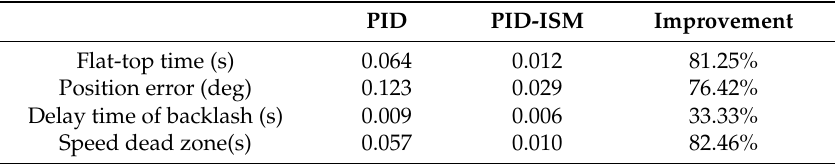
Table 2. Comparisons between traditional PID and PID-ISM.